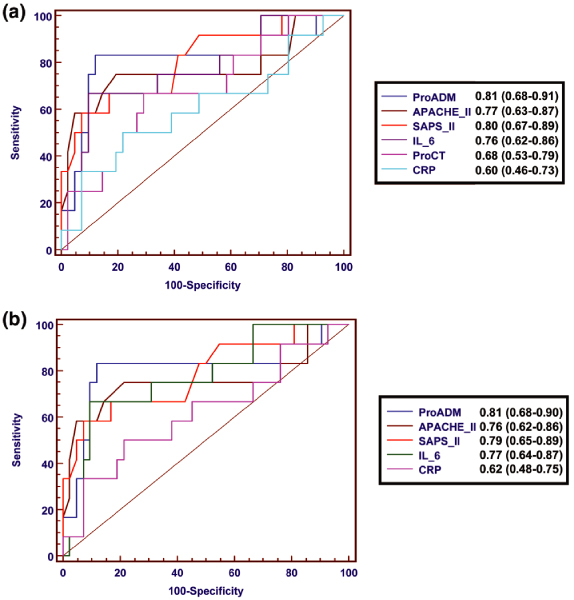
Sensitivity and specificity of various biomarkers and scoring systems in predicting ICU mortality. Shown are ROC plot analyses of the abilities of various biomarkers to predict outcome (for example ICU mortality) in sepsis. Patients are grouped into (a) those with a clinical diagnosis of sepsis based on international guidelines and (b) those with circulating PCT levels above 1 ng/ml. Sensitivity was calculated with patients who died during their ICU stay and specificity was calculated with ICU survivors. The areas under the ROC curve are given with 95% confidence intervals. ICU, intensive care unit; PCT, procalcitonin; ROC, receiver operating characteristic.